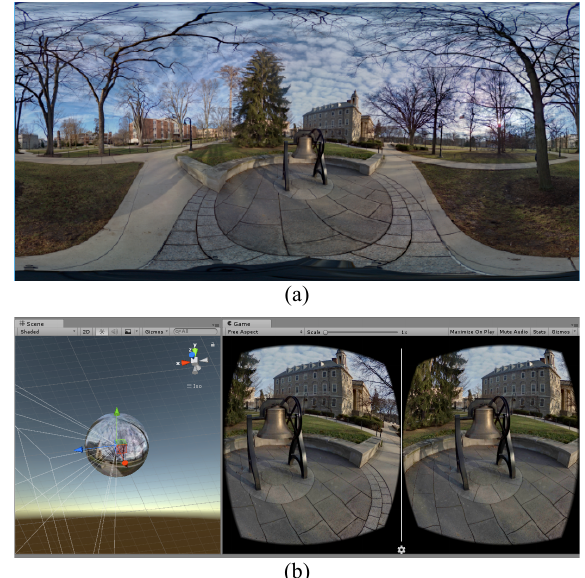
Figure 1. (a) Panono 360° image. (b) Scene in Unity3D with the image used to texture the inside of a sphere surrounding the camera and the corresponding rendered left-right eye camera images on the